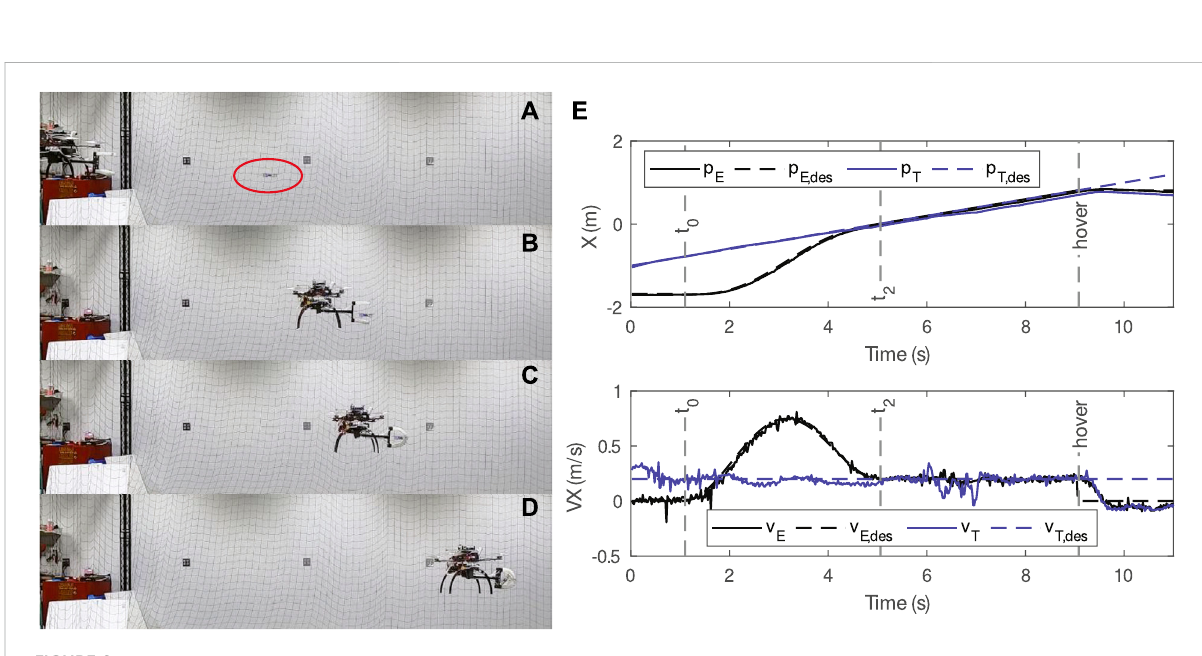
FIGURE 9 Asample trialofthedynamic catchingtest. (A – D) TheSoAGrobotchases,reachesandgraspsthemovingaerial target. (E) Statetrackingforthe end-effector and moving target. Note that the planning skips the chase segment due relatively close starting